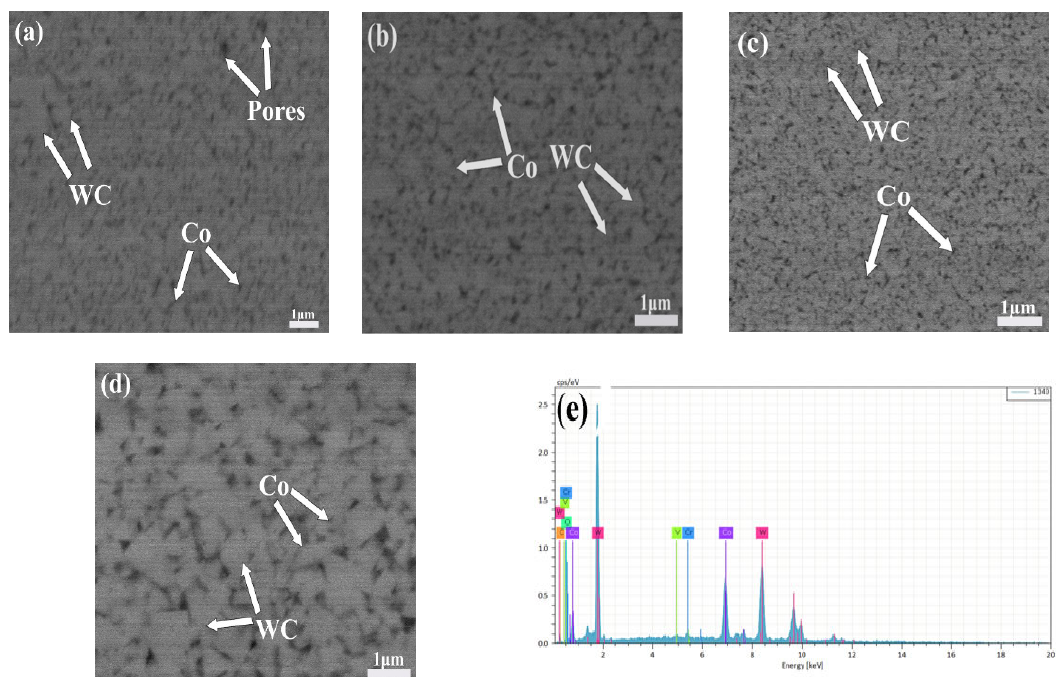
Figure 6. BSE images of specimens sintered at 1300 °C for different holding times ( a ) 20 min; ( b ) 40 min; ( c ) 60 min; ( d ) 80 min; ( e ) EDS spectrum of the sintered specimen (60 min).